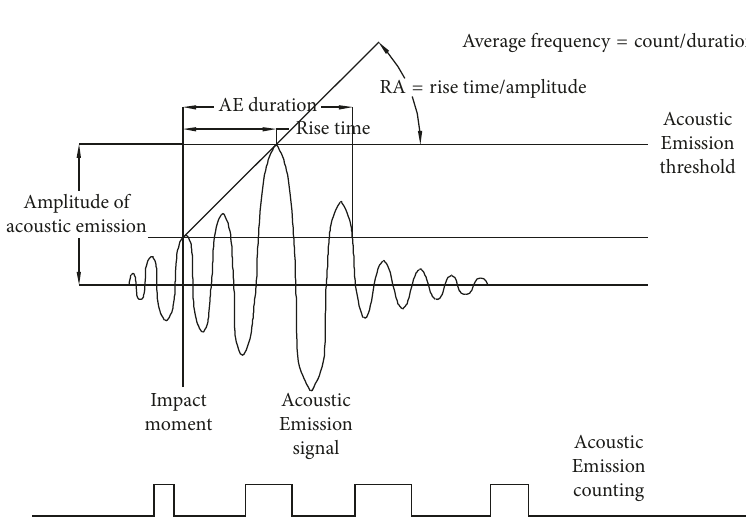
Figure 9: The principle of acoustic emission parameters calculation based on wave velocity.